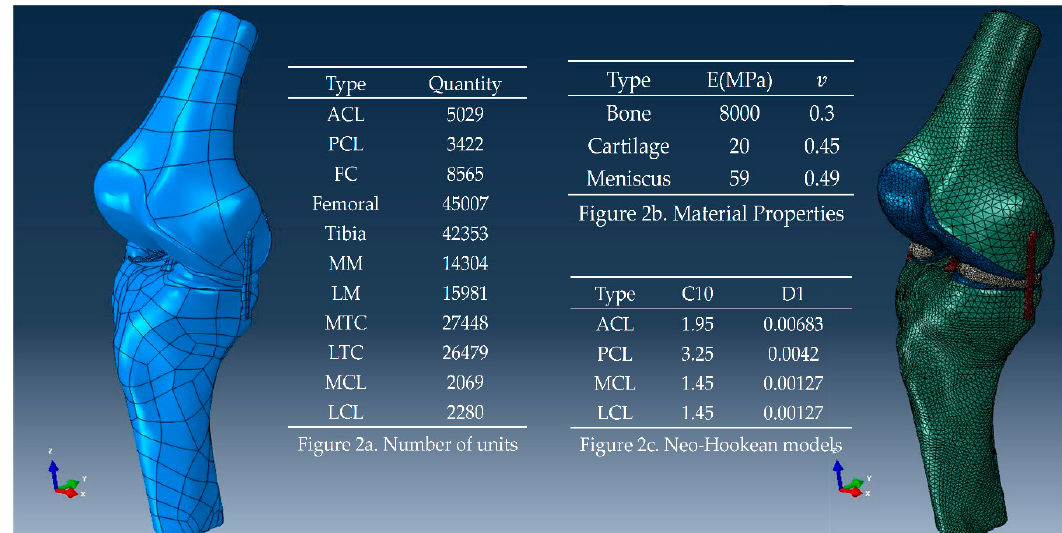
Figure 2. Mesh generation and material properties of knee models. The right figure represents assembled knee model. In the left figure, different colors define the different material properties. ACL: anterior cruciate ligament; PCL: posterior cruciate ligament; FC: femoral cartilage; MM: medial meniscus; LM: lateral meniscus; MTC: medial tibial cartilage; LTC: lateral tibial cartilage; MCL: medial collateral ligament; LCL: lateral collateral ligament.